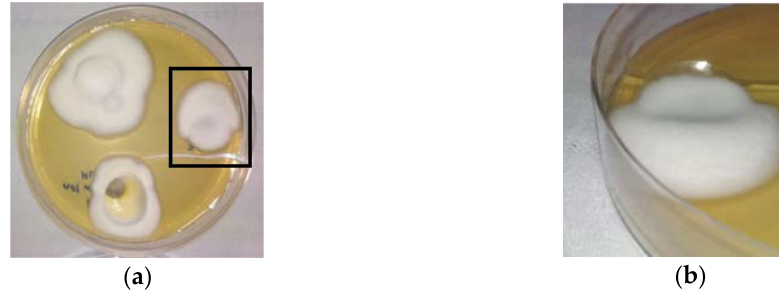
Figure 8. Keratin films infected by the dermatophyte T. rubrum : ( a ) a top view and ( b ) a side view of the film framed in Figure 8a.